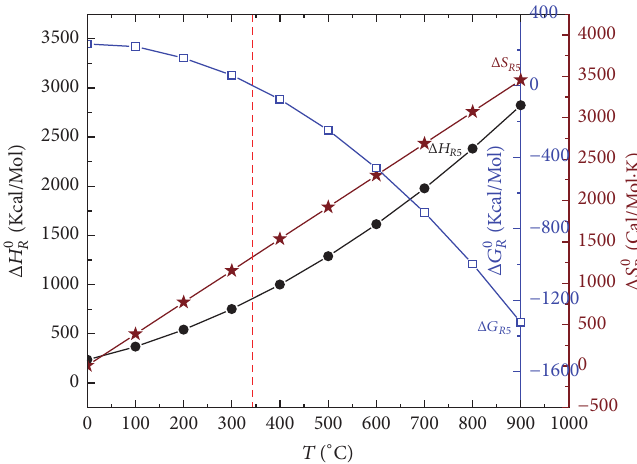
Figure 7: Variation of thermodynamic parameters for olivine